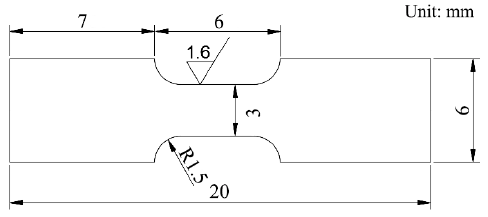
Figure 2. Tensile Figure 2. Tensile specimen.